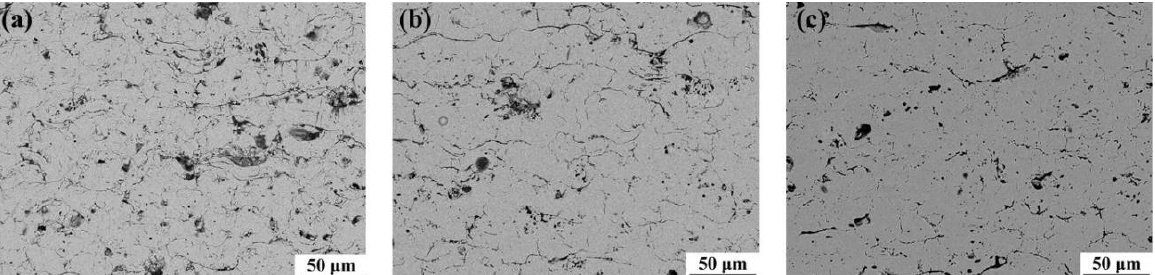
Fig. 30 Evolution of the polished cross-section of plasma-sprayed TBCs during thermal exposure at 1400 ℃ : (a) 0 h, (b) 20 h, and (c) 100 h. Reproduced with permission from Ref. [13], © ASM International